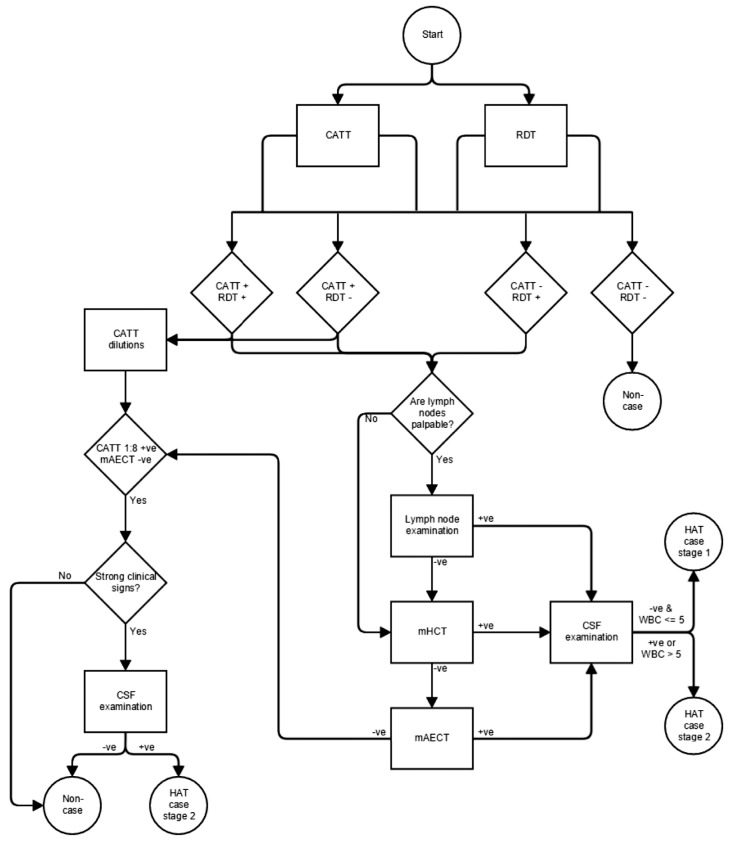
Flow diagram of the diagnostic algorithm.